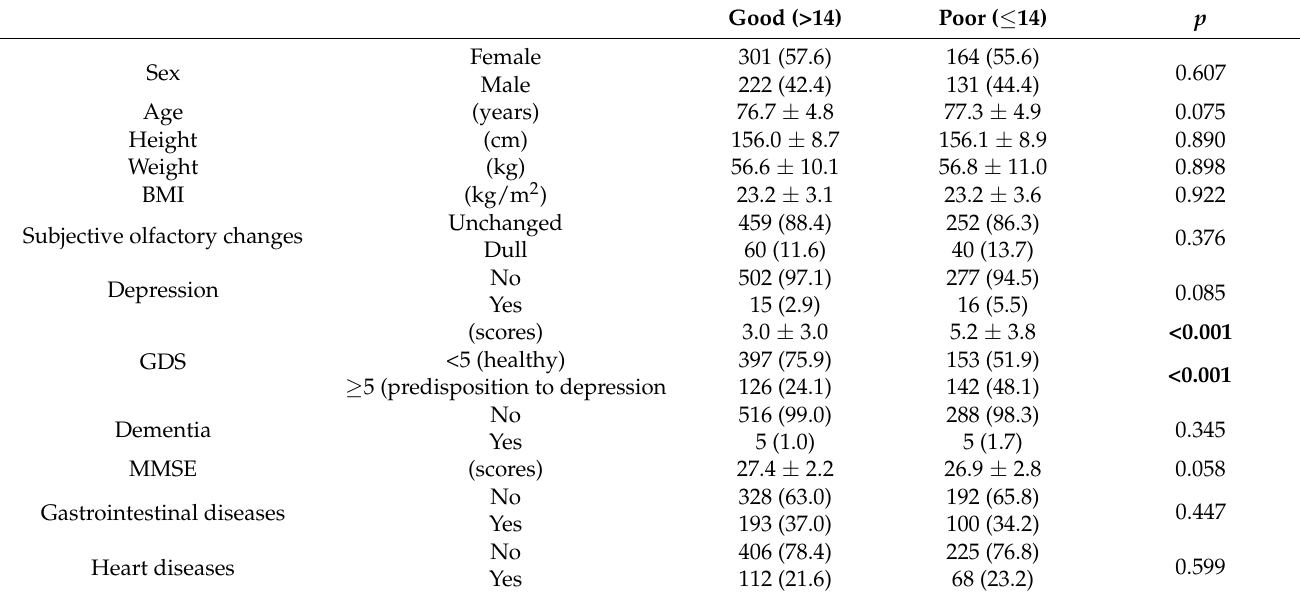
Table 1. Comparison between appetite and baseline